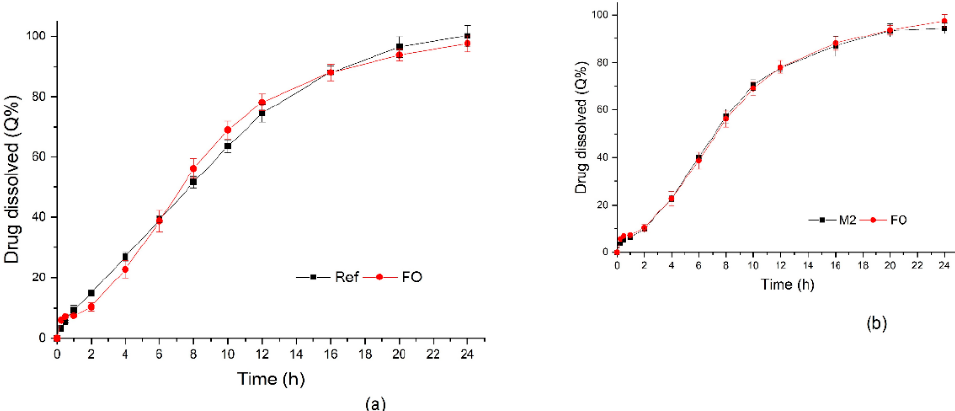
Figure 7. Dissolution profiles of ( a ) FO and Selopress Zok ® and ( b ) a comparison between simulated